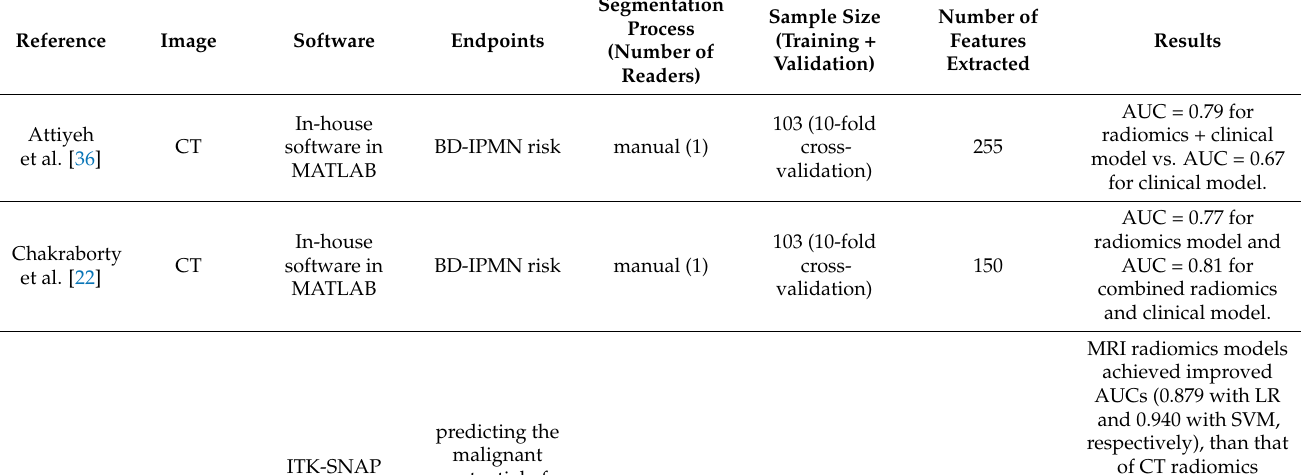
Table 1. Radiomics studies in diagnosing precancerous pancreatic